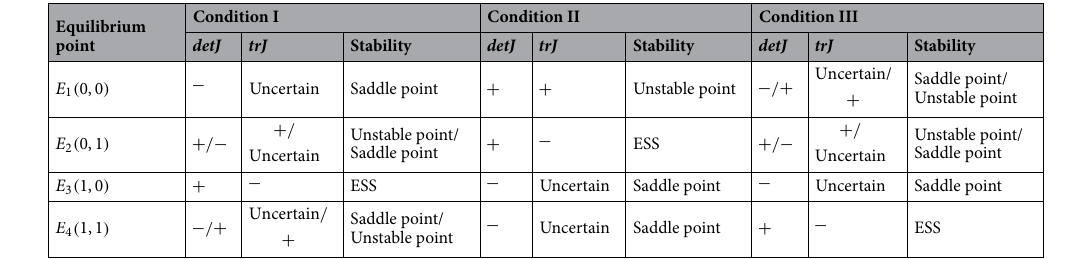
Table 4. Stability analysis under different